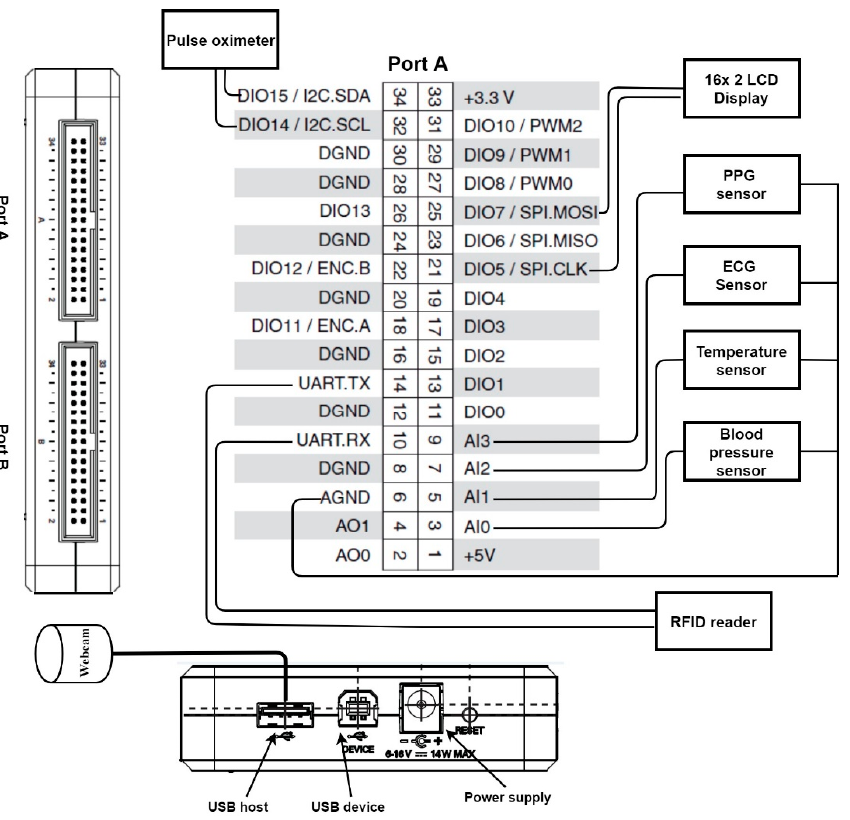
Figure 4 . Pin diagram for interconnections between myRIO-1900 and the sensors . Figure 4. Pin diagram for interconnections between myRIO-1900 and the sensors.